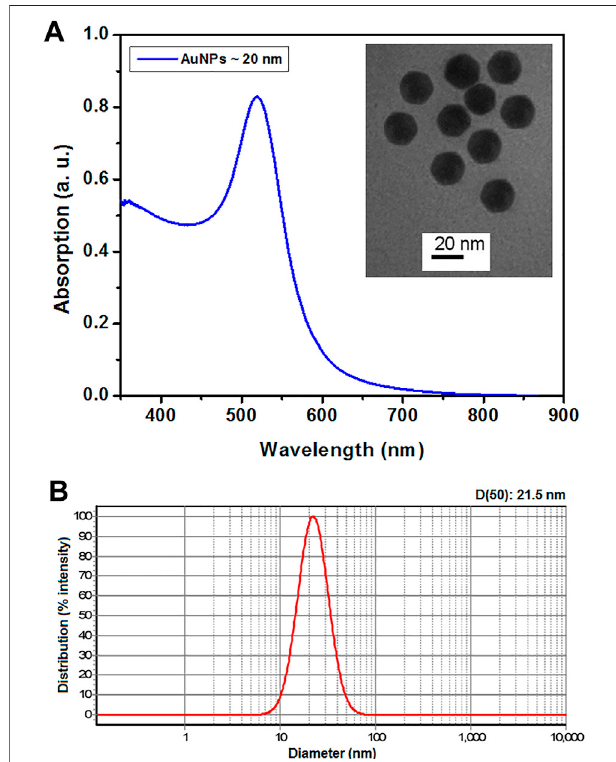
FIGURE 1 | UV – Vis absorption spectrum of AuNPs and transmission electron micrograph of the same (inset) (A) . The particle size distribution of AuNPs measured by DLS (B)